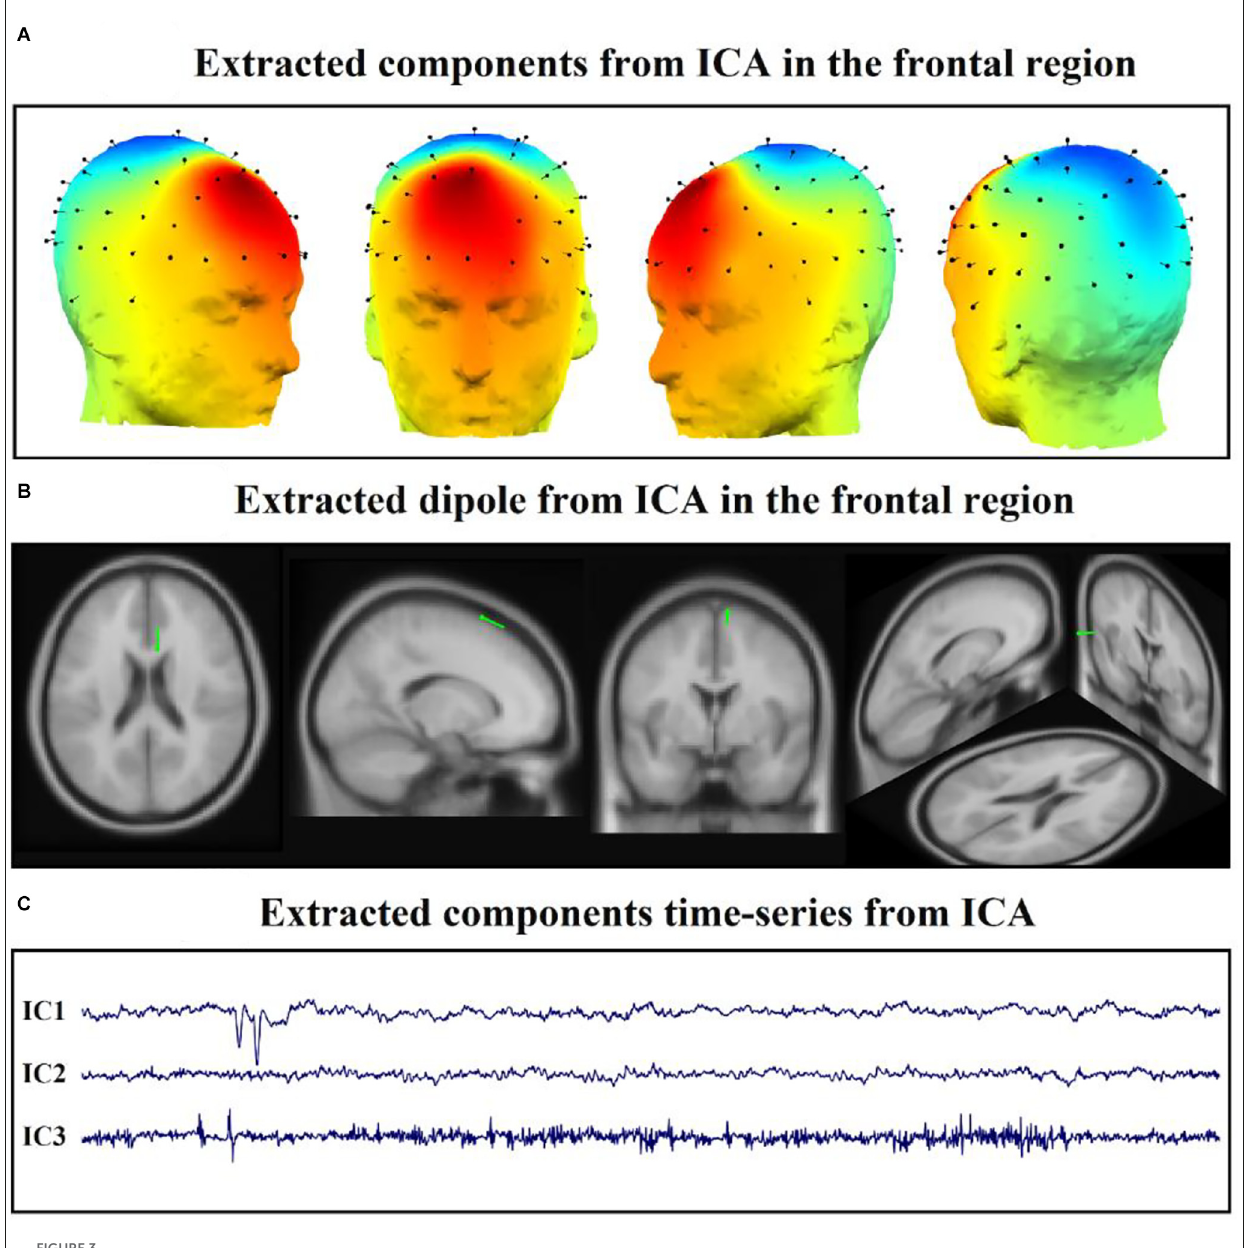
of neurons with a thickness varying from 1–4.5 mm